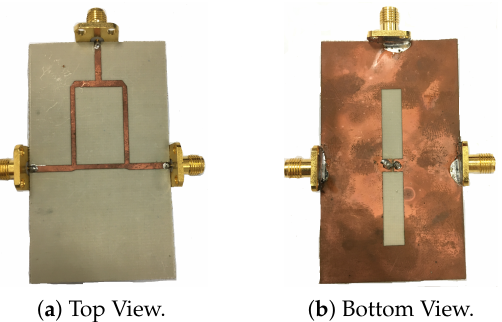
Figure 13. Photographs of the fabricated WPD circuit designed at 2 GHz. It is clear from the measured results that good agreement is achieved, and the overall results match the required specifications of the proposed Wilkinson power divider. The measured results are approximately identical to the simulated results and have acceptable results. The fabricated circuits designed at resonating frequencies of 3 and 2 GHz have relatively good return losses S 11 of about − 25.54 and − 31.24 dB, respectively, and achieve good isolations between its output ports, in an order of about S 32 = − 40.83 and − 36.05 dB within the operating bandwidth, respectively, which is rather exceptional and acceptable. Both Ports 2 and 3 of both dividers achieve approximately equally divided power, i.e.,